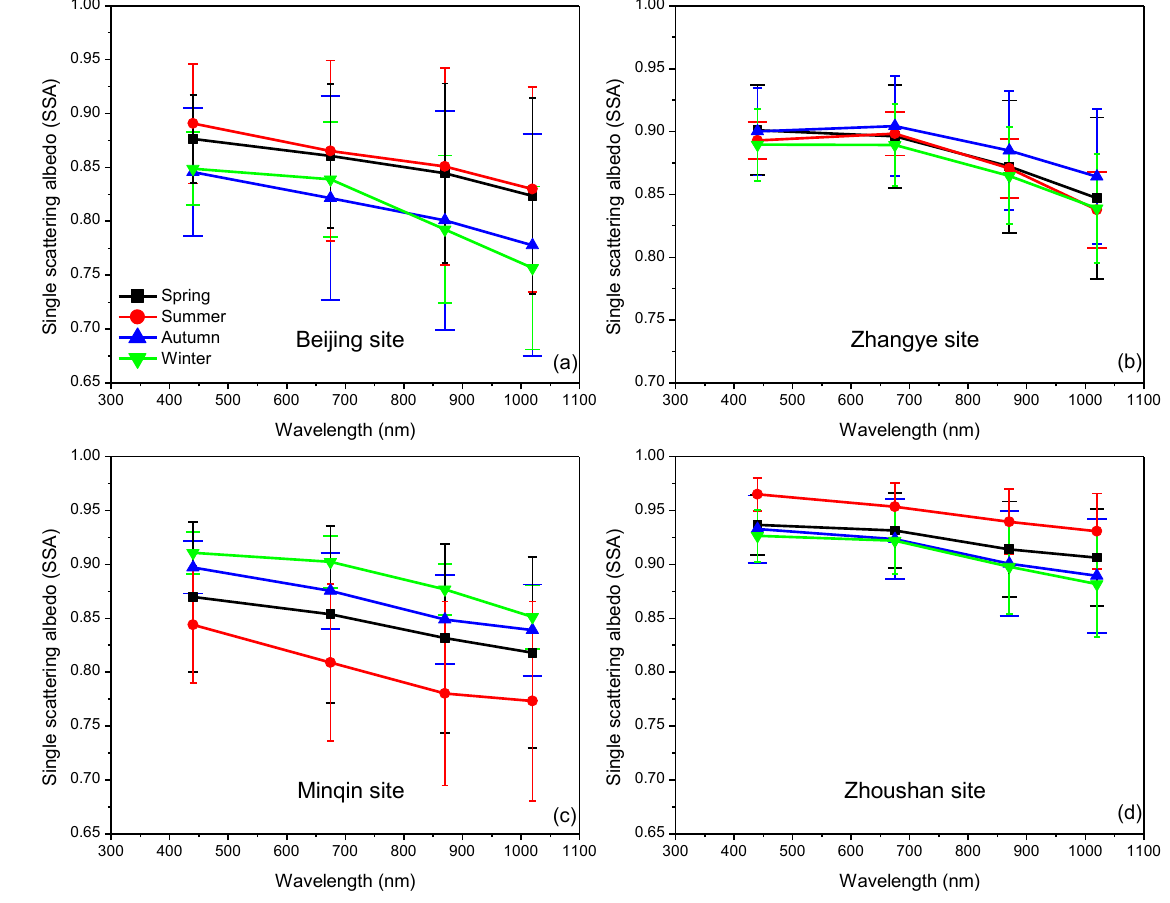
Figure 7. Seasonal average of single scattering albedo of the four sites, ( a ) Beijing site; ( b ) Zhangye site; ( c ) Minqin site; ( d ) Zhoushan site. Error bar indicates the standard deviation of the